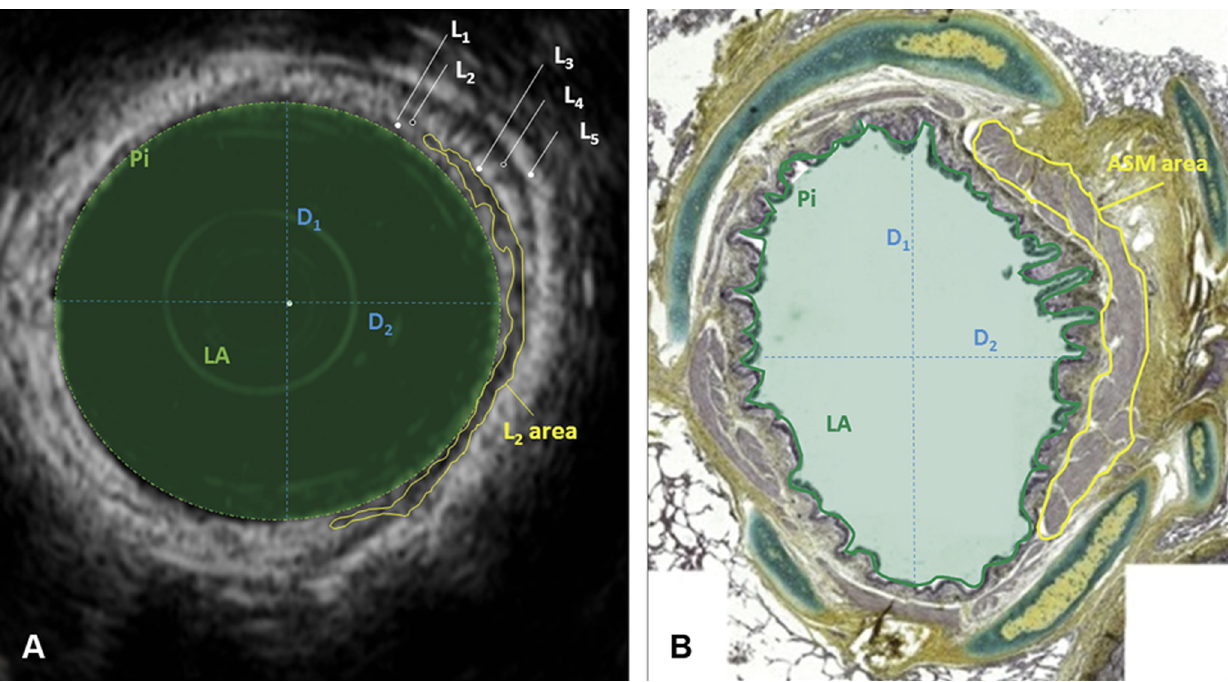
Fig 2. Measurements made on EBUS (A) and histological (B) images. Only a part of L2 area and ASM area have been encircled in yellow, to allow the reader appreciate the rest of the image. L: US layer; D 1 and D 2 : perpendicular diameters (blue dotted lines); LA: lumen area (filled light green area); Pi: airway perimeter (continuous green